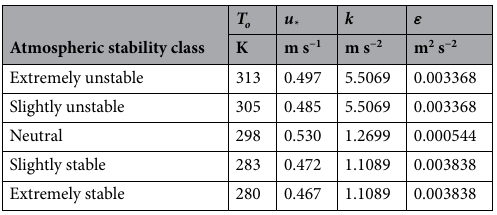
Table 2. Parameters used to describe atmospheric stability